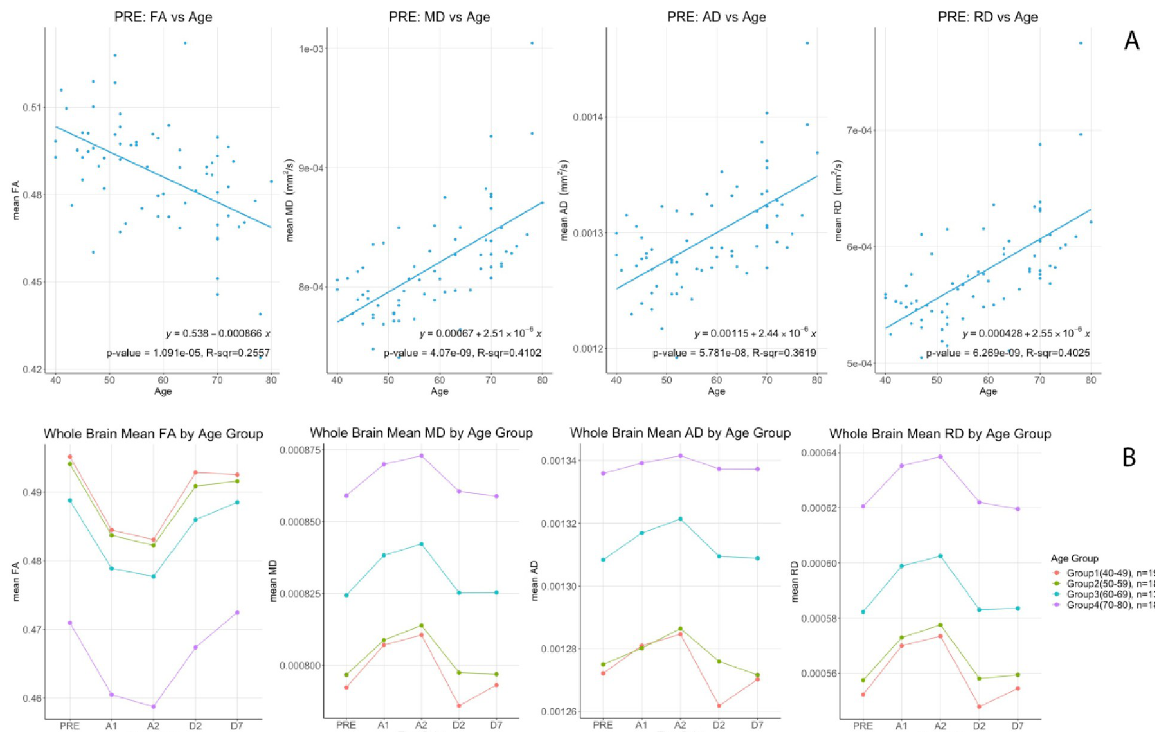
Fig 3. Top (A) DTI metrics (FA, MD, AD & RD) correlations versus age at baseline (PRE). Bottom (B) Differential changes of (FA, MD, AD & RD) by age groups for the 5 time points.